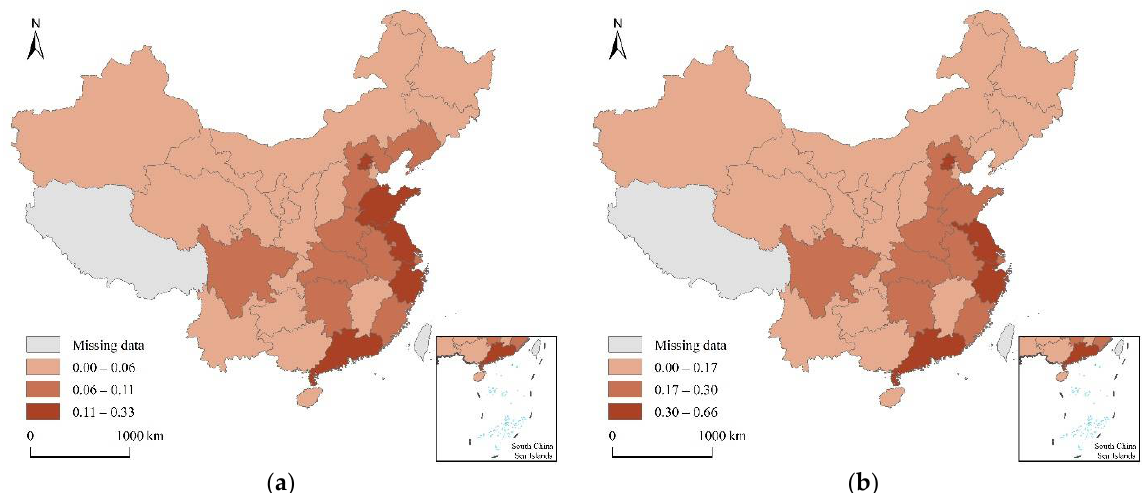
Figure 7. The distribution of informatization development in 2013 and 2020. ( a ) 2013; ( b )